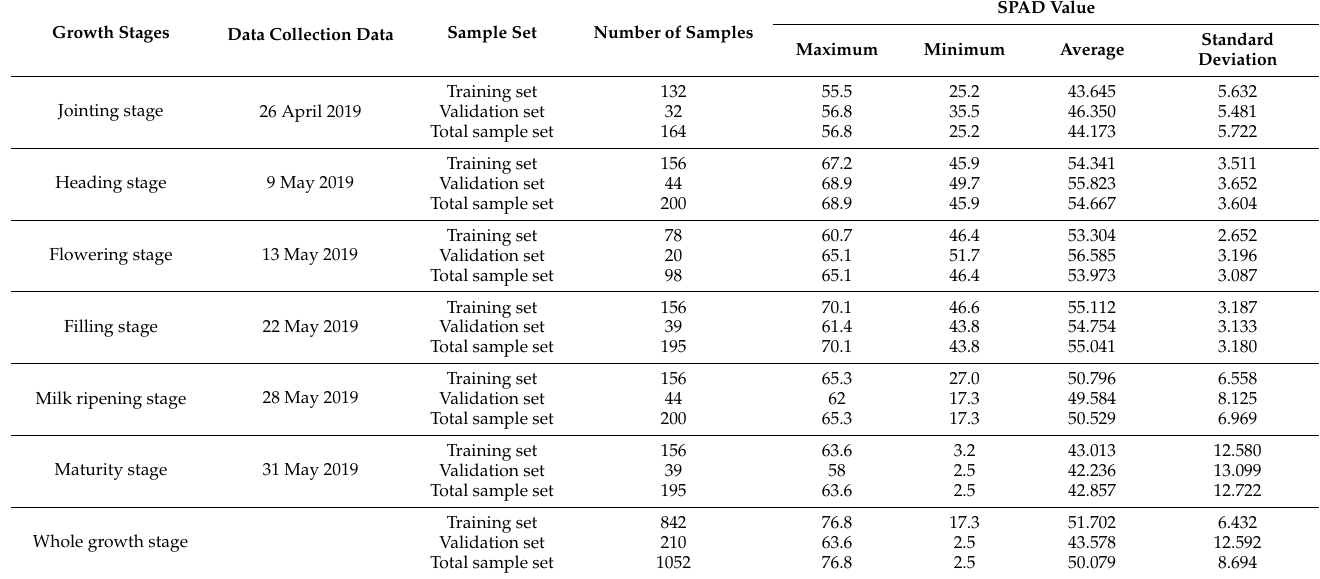
Table 1. The introduction of winter wheat sample sets on each growth